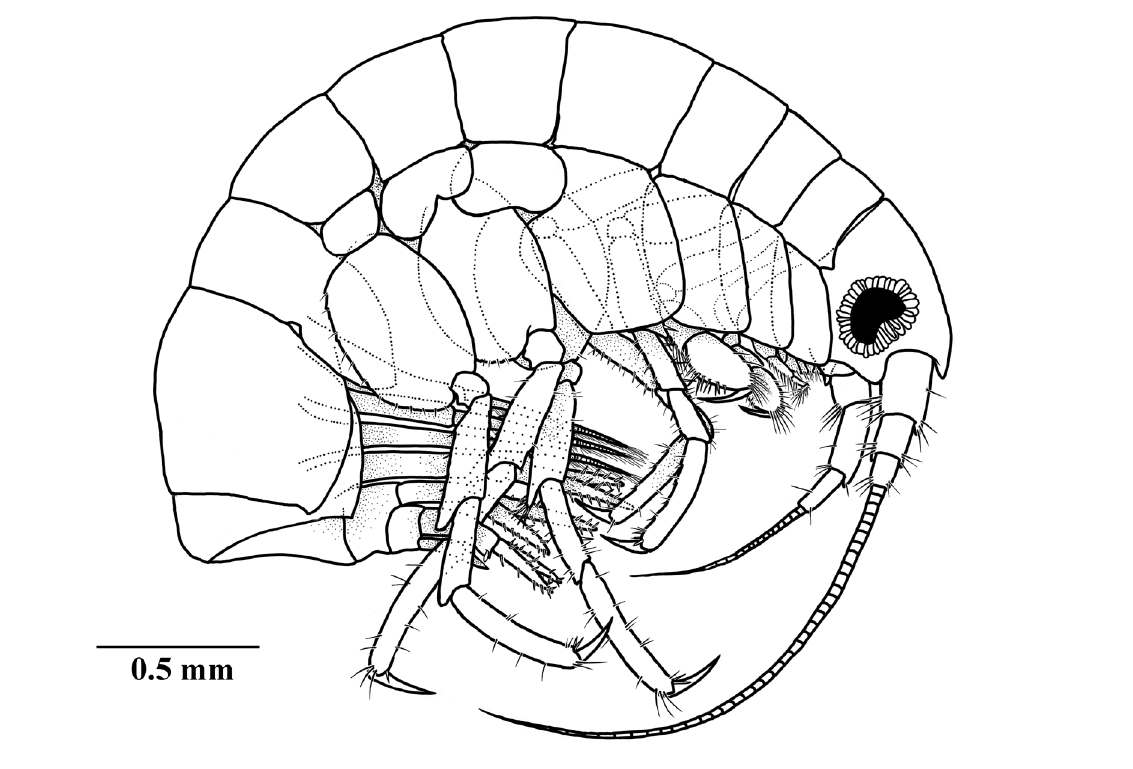
Fig. 1. General view (habitus) of Pleusymtes actiniae sp. nov., holotype, ♀, from Dolgay Bay, Barents Sea (ZMMU